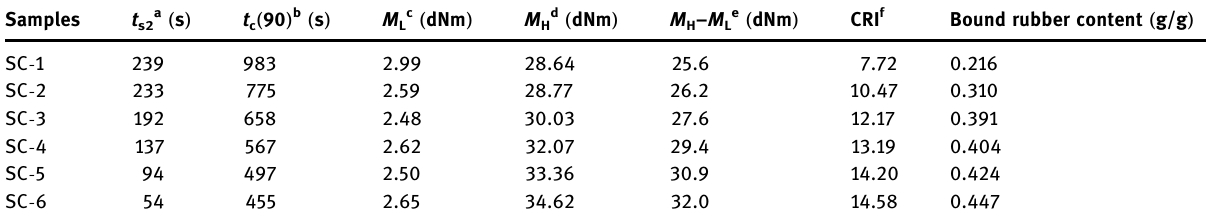
Table 2: Vulcanization characteristics and bound rubber content of modi fi ed IR/silica/CB compounds with ATD Samples